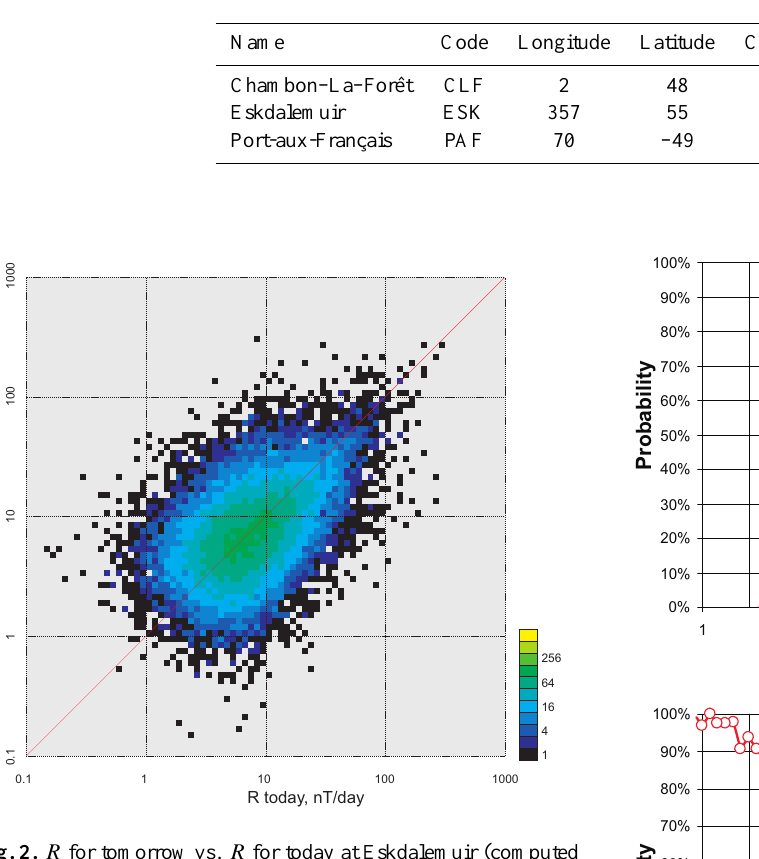
tional probabilities can be derived from the ( R(k) , R(k + 1 ) ) 2-D